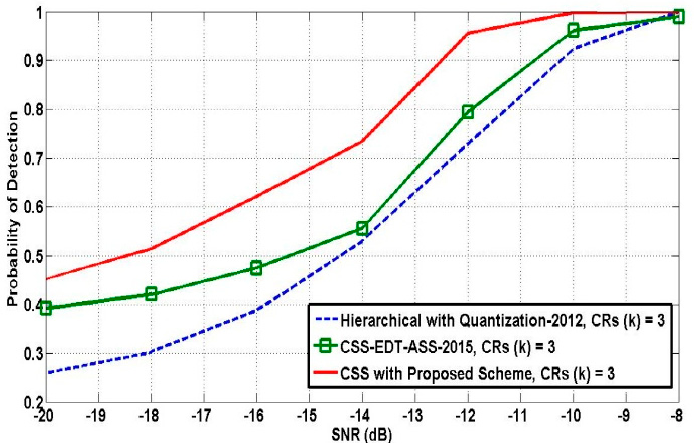
Figure 10. Comparison between CSS with the proposed scheme and existing sensing techniques for CRs k = 3.